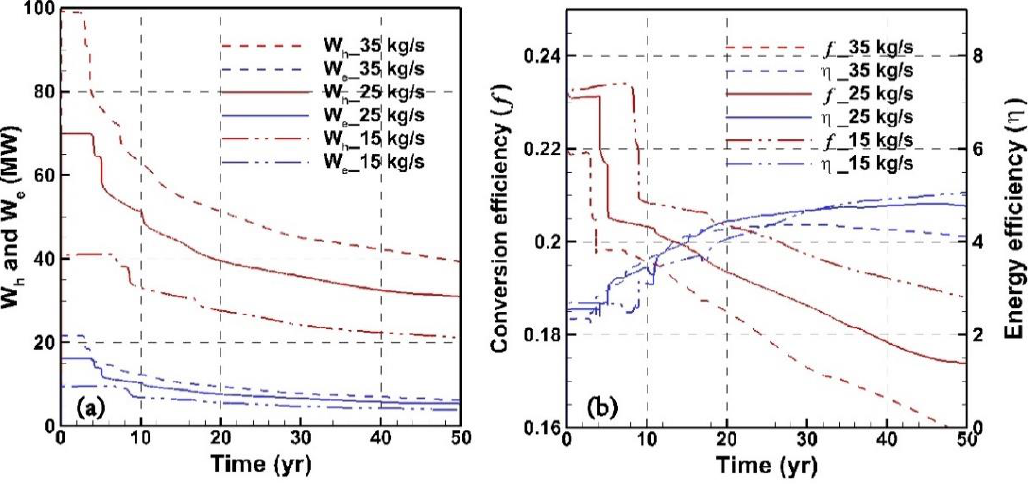
Figure 8. The evolution of net heat flow ( W h ), power generation ( W e ) ( a ), and conversion efficiency and energy efficiency ( b ) with different flow rates.